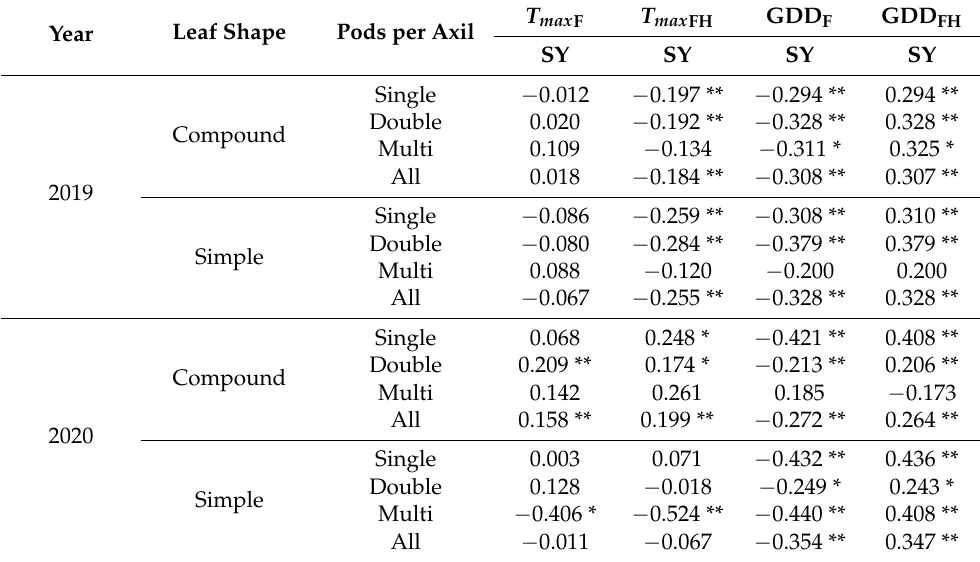
Table 2. Correlation coefficients (r) between seed yield and maximum temperatures from germina- tion to flowering ( T max F ) and from flowering to harvest ( T max FH ), and growing degree-days from germination to flowering (GDD F ) and from flowering to harvest (GDD FH ). T max F T max FH GDD F GDD FH Year Leaf Shape Pods per Axil SY SY SY Single − Compound